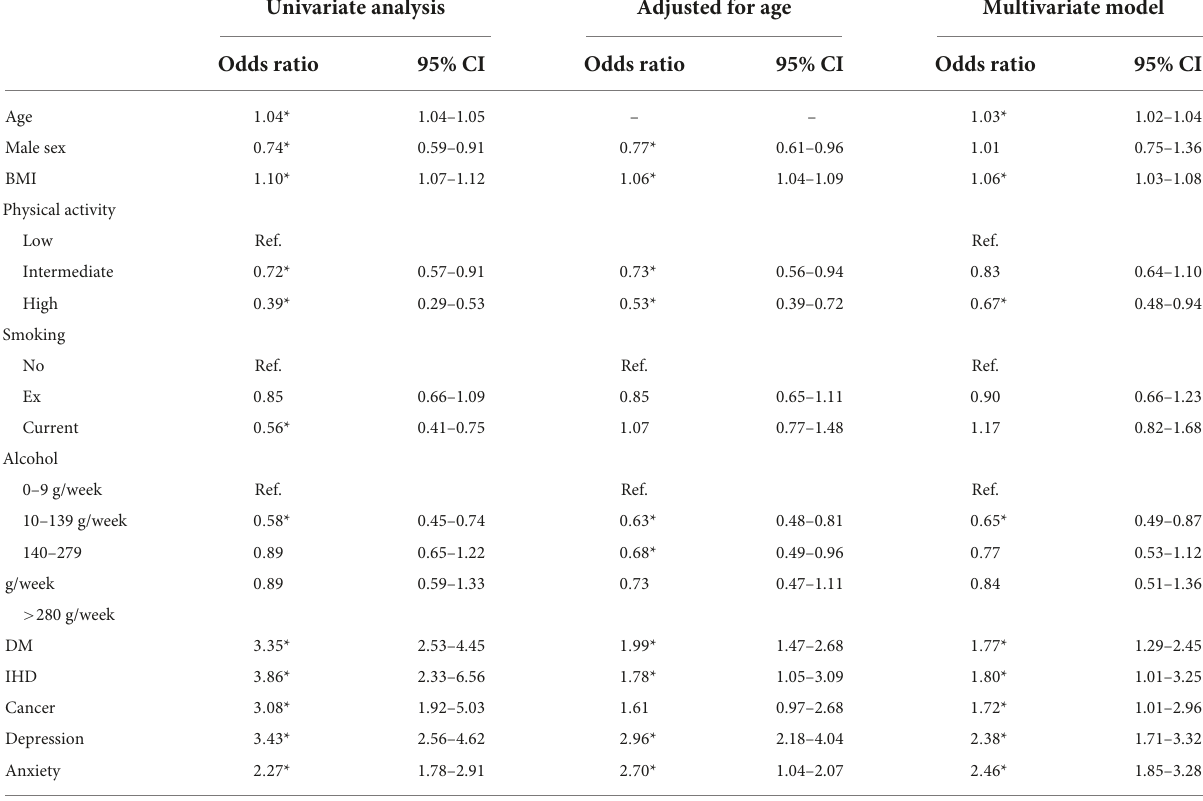
TABLE 2 Univariate and adjusted odds ratios for poor self-rated health and their 95% confidence interval. Univariate analysis Adjusted for age Multivariate